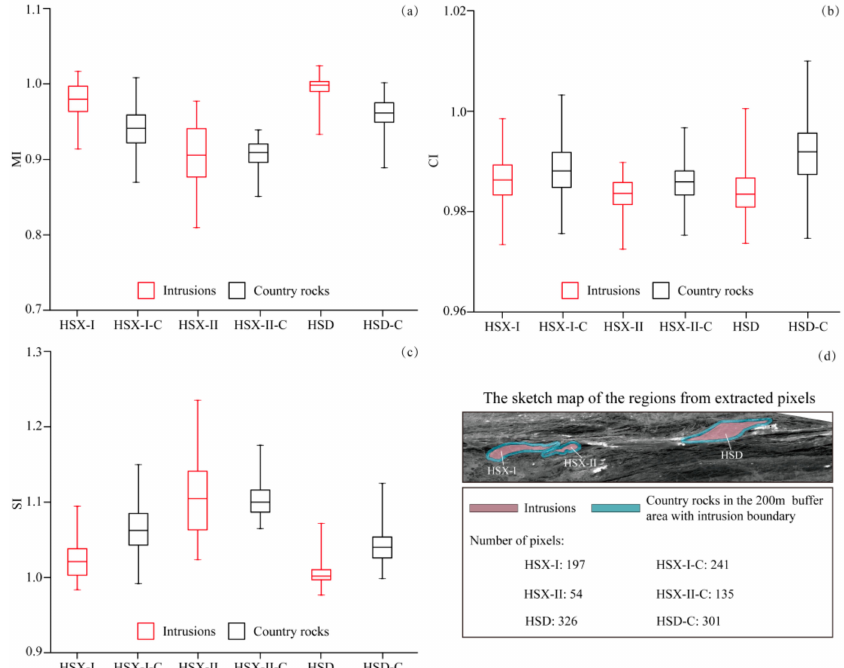
Figure 7. The quartile boxes of extracted pixels from the regions of HSX-I, HSX-II and HSD intrusions and their country rocks in the 200 m buffer area with intrusion boundary in the ASTER mafic index (MI) ( a ), carbonate index (CI) ( b ), silica index (SI) ( c ) images. The regions from extracted pixels in detail are shown in the sketch map, and number of pixels also are given ( d